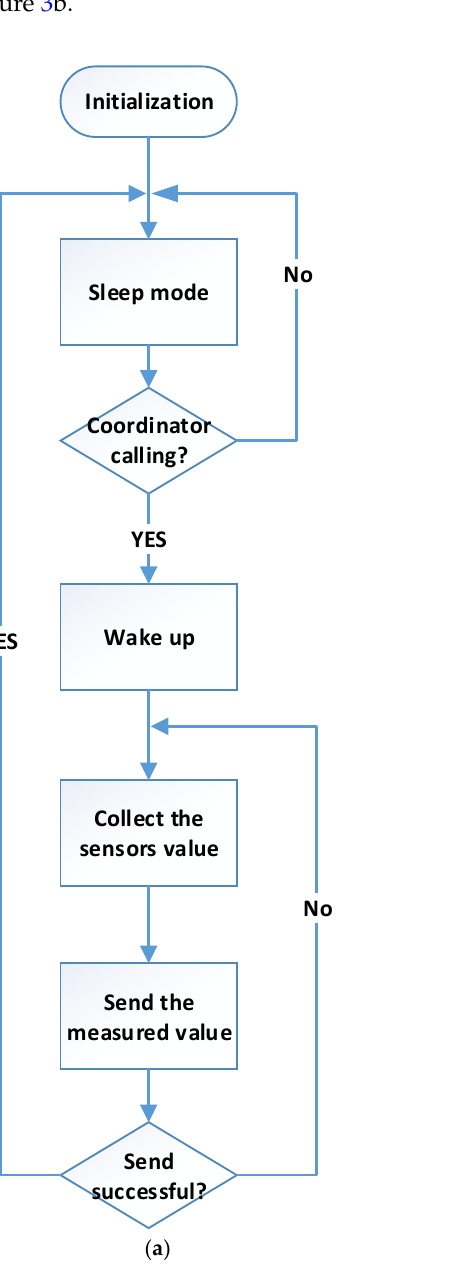
Figure 3. The flow charts of ( a ) communication process of sensor node; and ( b ) communication process of coordinator.